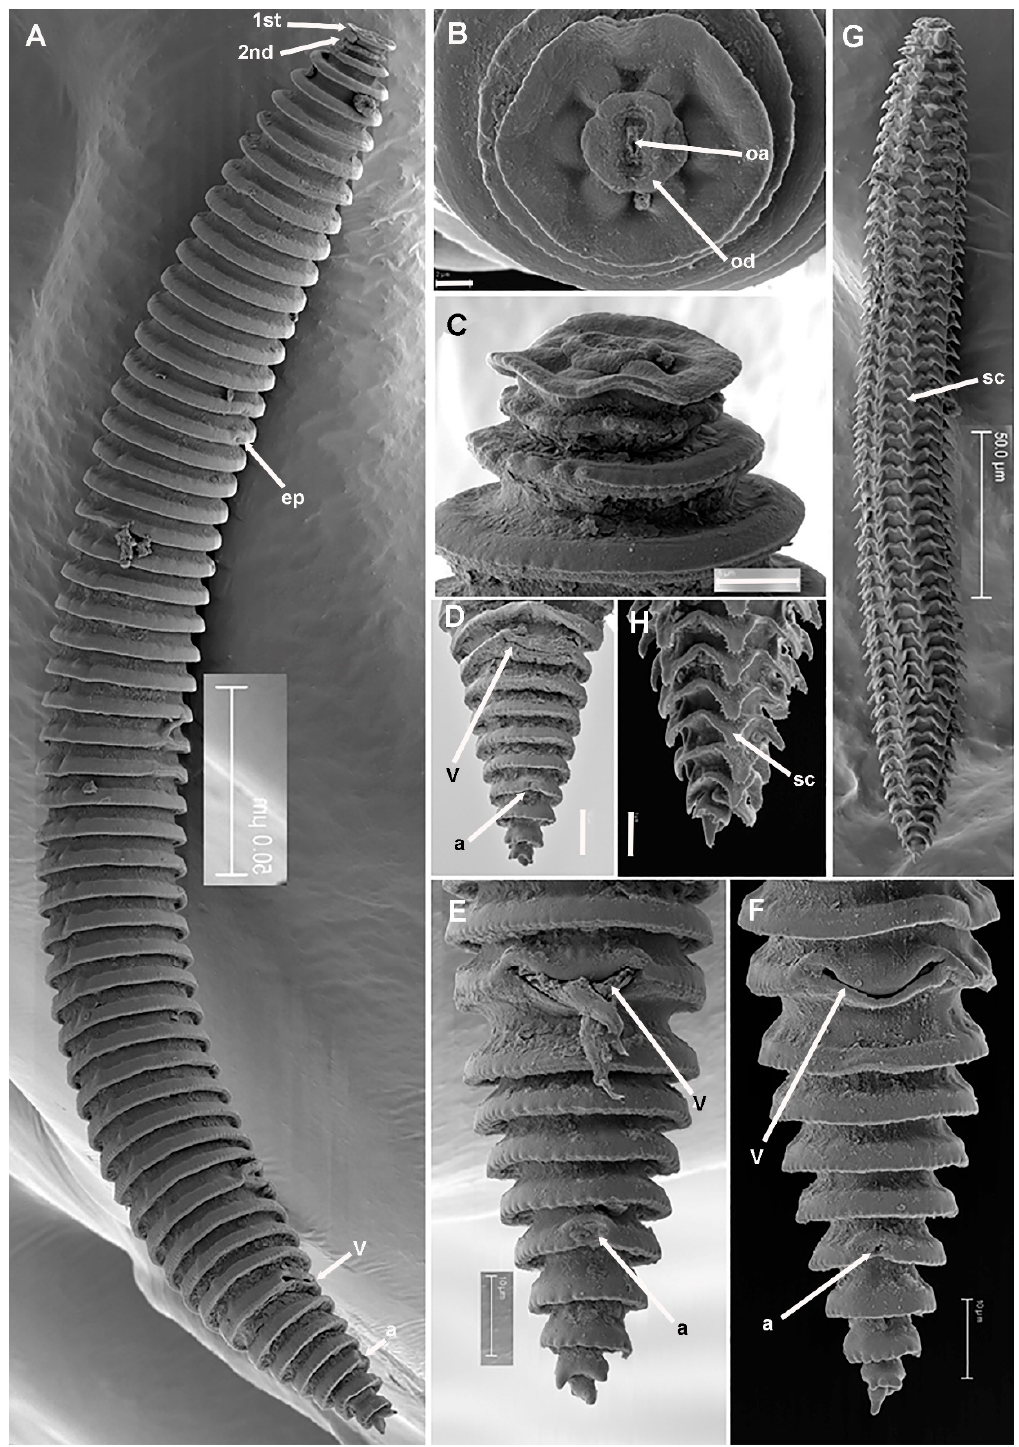
Figure 6. SEM micrographs of Criconema paraannuliferum sp. nov. female and fourth-juvenile stage. ( A ), whole female; ( B ), female in face view showing oral disc and oral aperture (arrowed); ( C ), detail of 1st and 2nd body annuli; ( D – F ), posterior region showing vulva and anus (arrowed); ( G ), whole juvenile showing files of scales; ( H ), posterior region showing files of scales (arrowed) and minute acute projections. Abbreviations: a = anus; ep = excretory pore; oa = oral aperture; od = oral disc; sc = scales; V = vulva; 1st, 2nd = first- and second-body annuli. Scale bars: ( A , G ) = 50 µm; ( B ) = 2 µm; ( C ) = 5 µm; ( D – F , H ) = 10 µm.